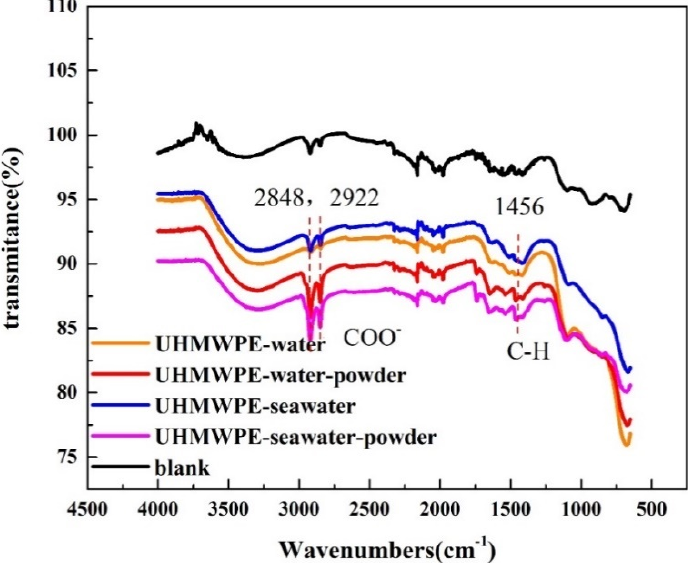
Figure 7. Infrared spectrogram of aluminum surface of grinding components.